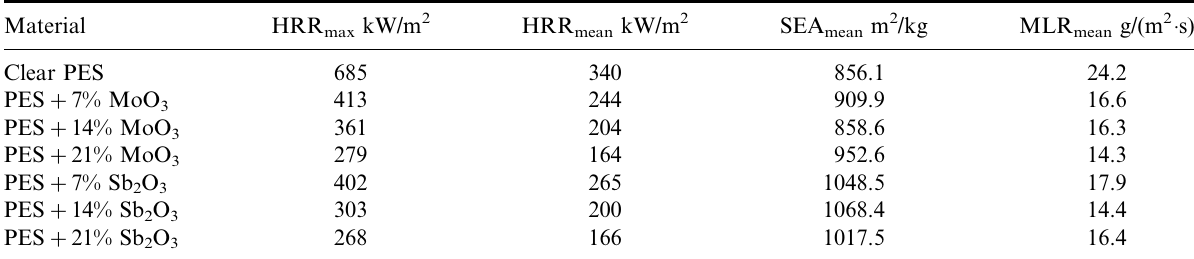
Table 3. Thermo-kinetic properties of polyester materials containing Polimal 1033 APy unmodified and modified with inorganic oxides under ignition conditions for the external heat flux of 30 kW/m 2 (cid:2) Part 1 Material